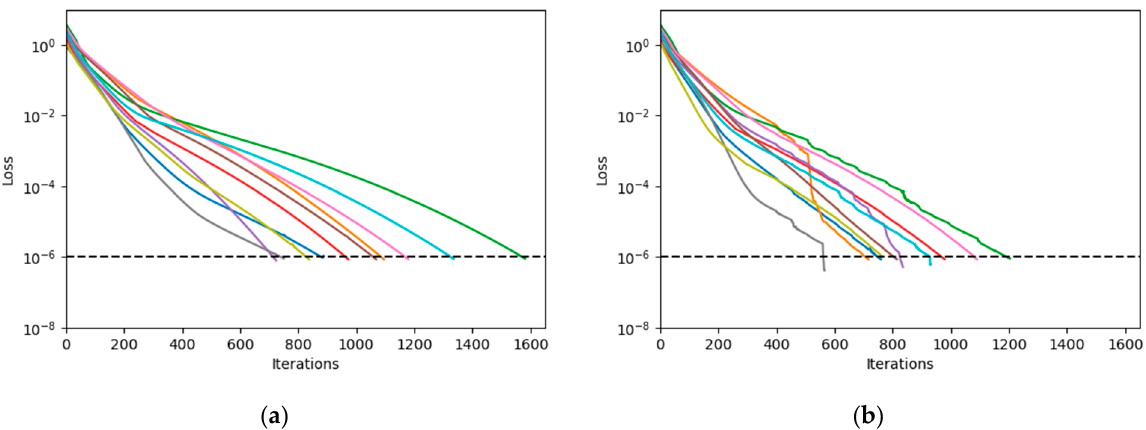
Figure 8. ( a ) Training history for the unsupervised training of the PINN model of the heat exchanger network using only the Adam optimizer; ( b ) Training history for the unsupervised training of the PINN model of the heat exchanger network using a combination of the Adam optimizer and the truncated Newton method. The various colors each represent a different sample of the same simulation.